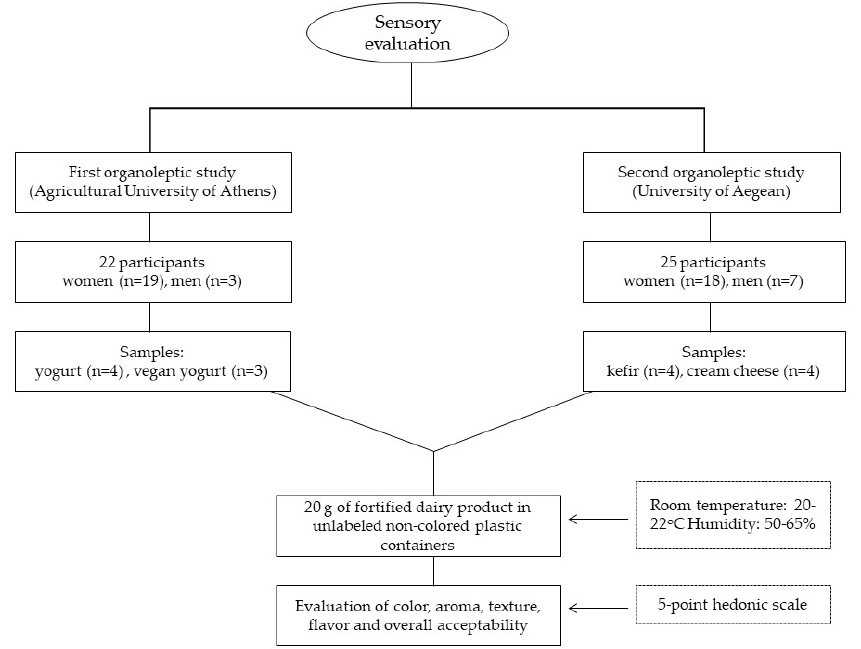
Figure 1. Flow diagram of organoleptic study.